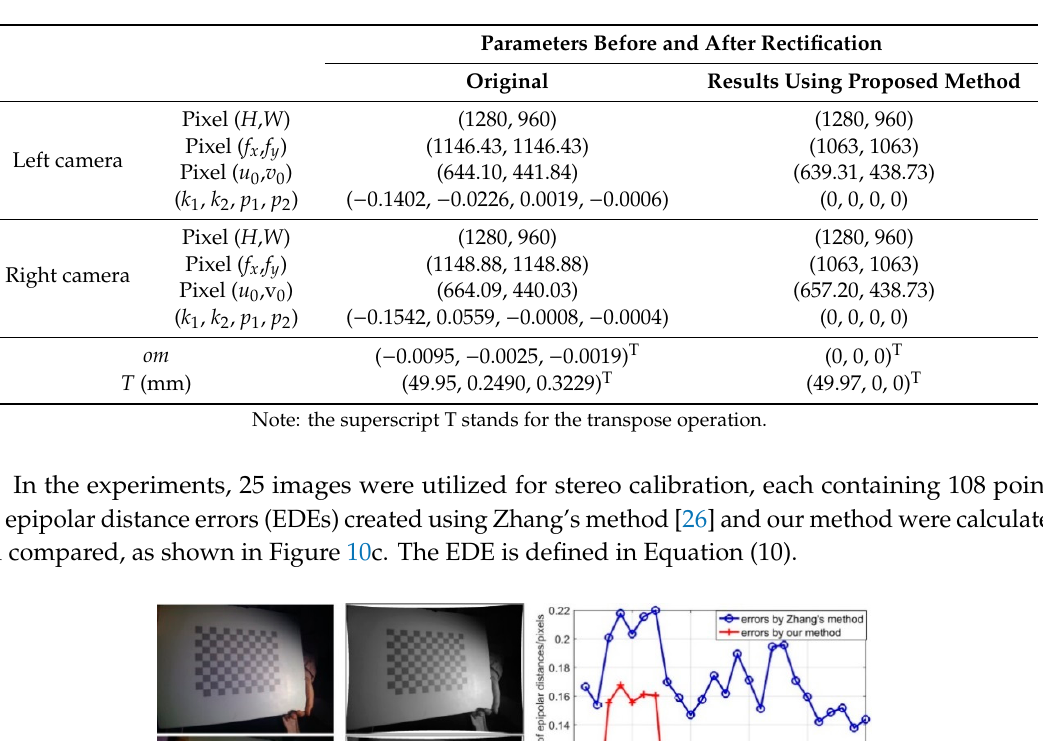
Figure 9. Experimental setup.